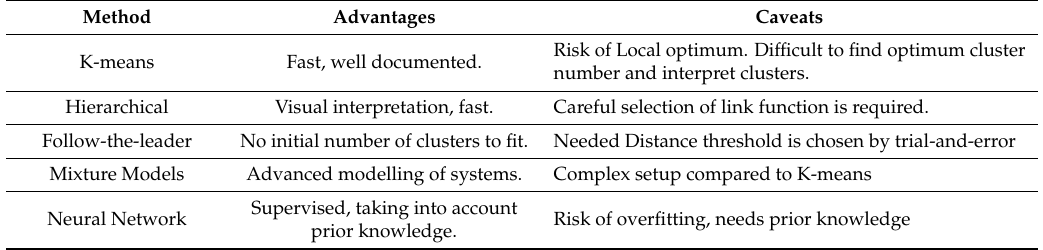
Table 6. Overview of the most prevalent classification methods encountered in the 34 papers.